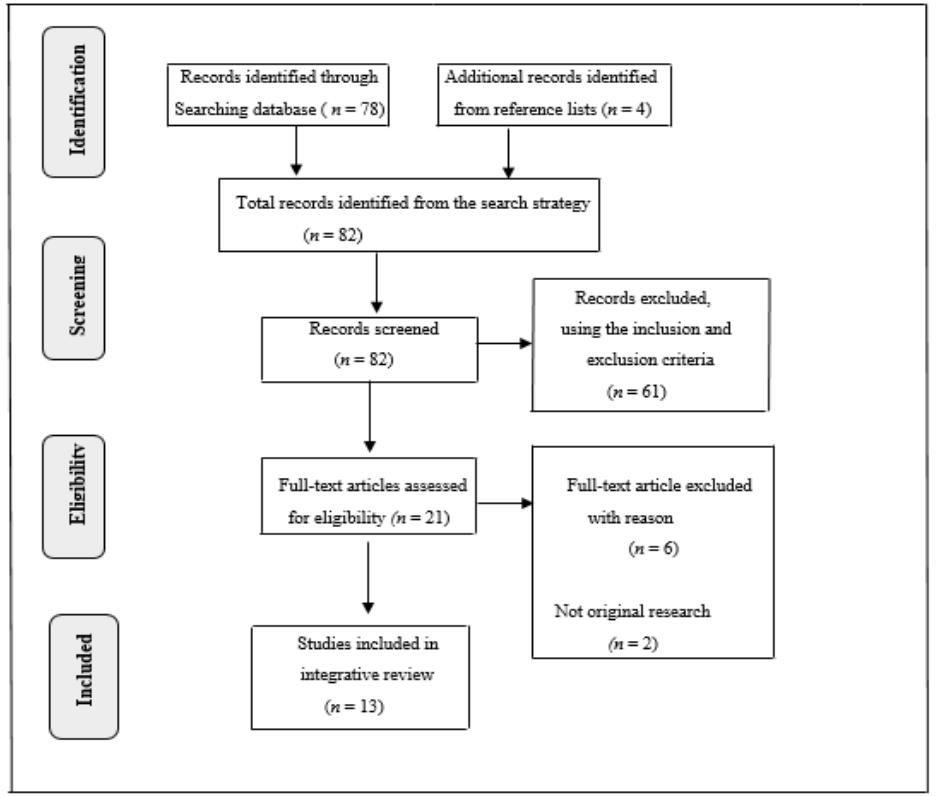
Figure 1. PRISMA flow diagram showing the search process for the included articles.